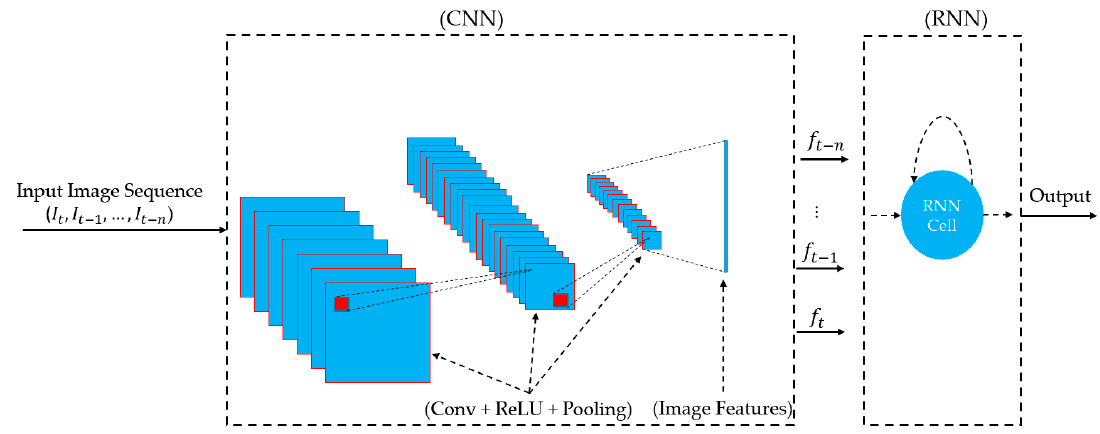
Figure 3. Demonstration of an RNN network: ( a ) a simple RNN cell; ( b ) structure of a standard LSTM cell.